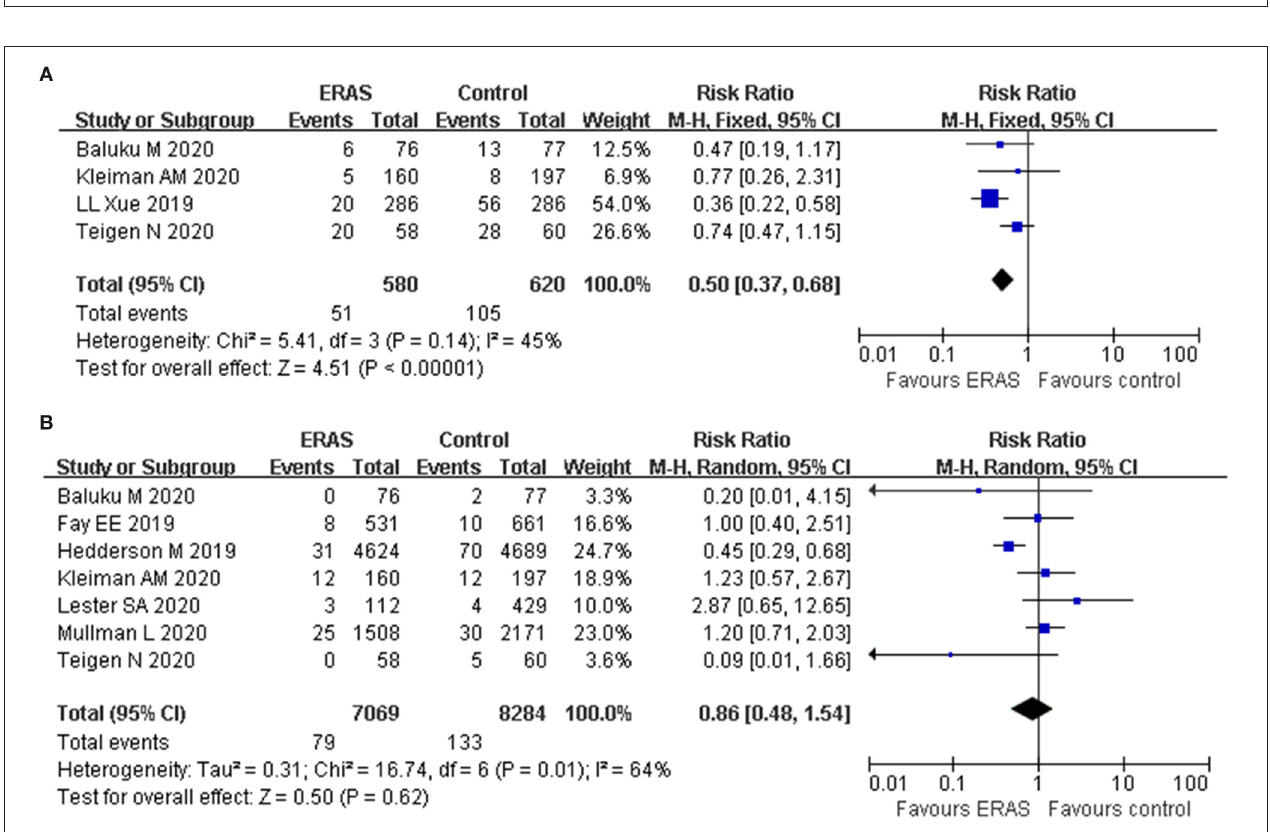
FIGURE 3 | Forest plots assessing the outcomes of length of hospital stay (hours).